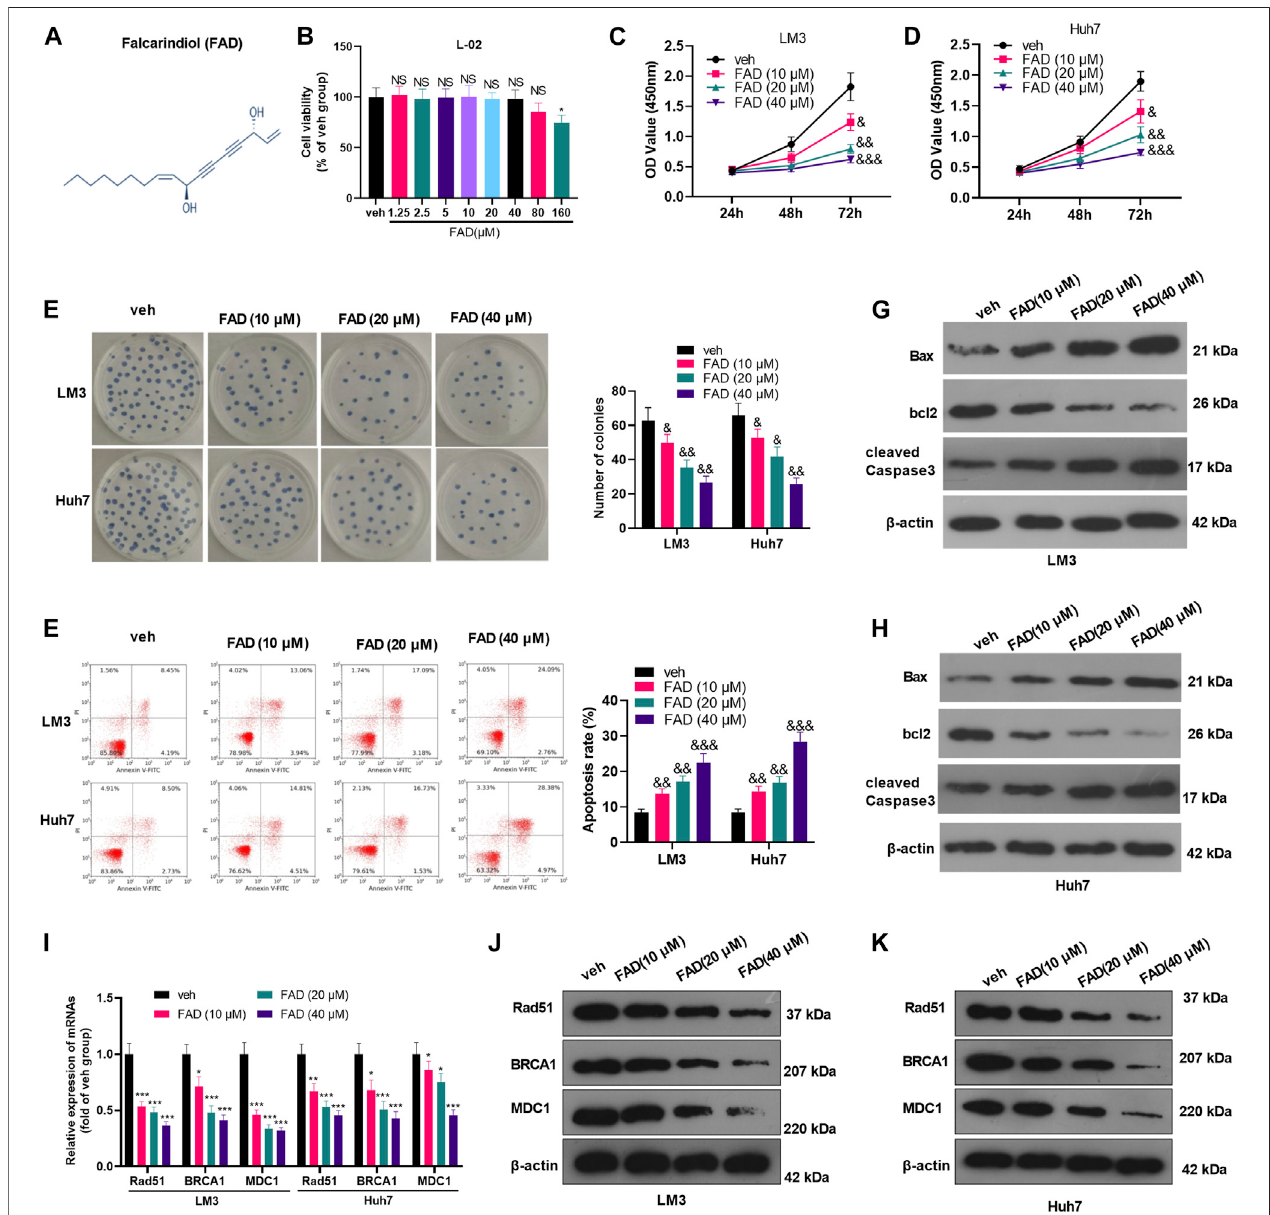
FIGURE 1 | FAD reduced the proliferation and induced apoptosis of HCC cells (A) . The chemical structure of FAD was shown. (B) . Human normal liver L-02 cells weretreatedwithdifferentdosesofFAD(0 – 160 μ M)for24 h,andCCK-8assaywasusedtotestcellviability,NS,*represents p > 0.05, p < 0.05,respectively.C-E.HCC cells (including Huh7 and LM3) were treated with 10 – 40 μ M of FAD for 24 h. The proliferation of HCC cells was evaluated by CCK-8 assay (C – D) and colony formation assay (E) . (F) . FCM was carried out to test cell apoptosis (G – H) . WB was performed to determine the apoptosis-related proteins (including Bax, bcl2, and cleaved Caspase3) of HCC cells. &, &&, &&& represents p < 0.05, p < 0.01, p < 0.001, respectively. N (cid:2) 3. I-K. qRT-PCR (I) and WB (J – K) were used for detecting DNA repair- relatedgenes/proteins(includingRad51,BRCA1,andMDC1) inHuh7 andLM3 treatedwith10 – 40 μ MofFADfor24 h*,**,***represents p < 0.05, p < 0.01, p < 0.001, respectively. N (cid:2)